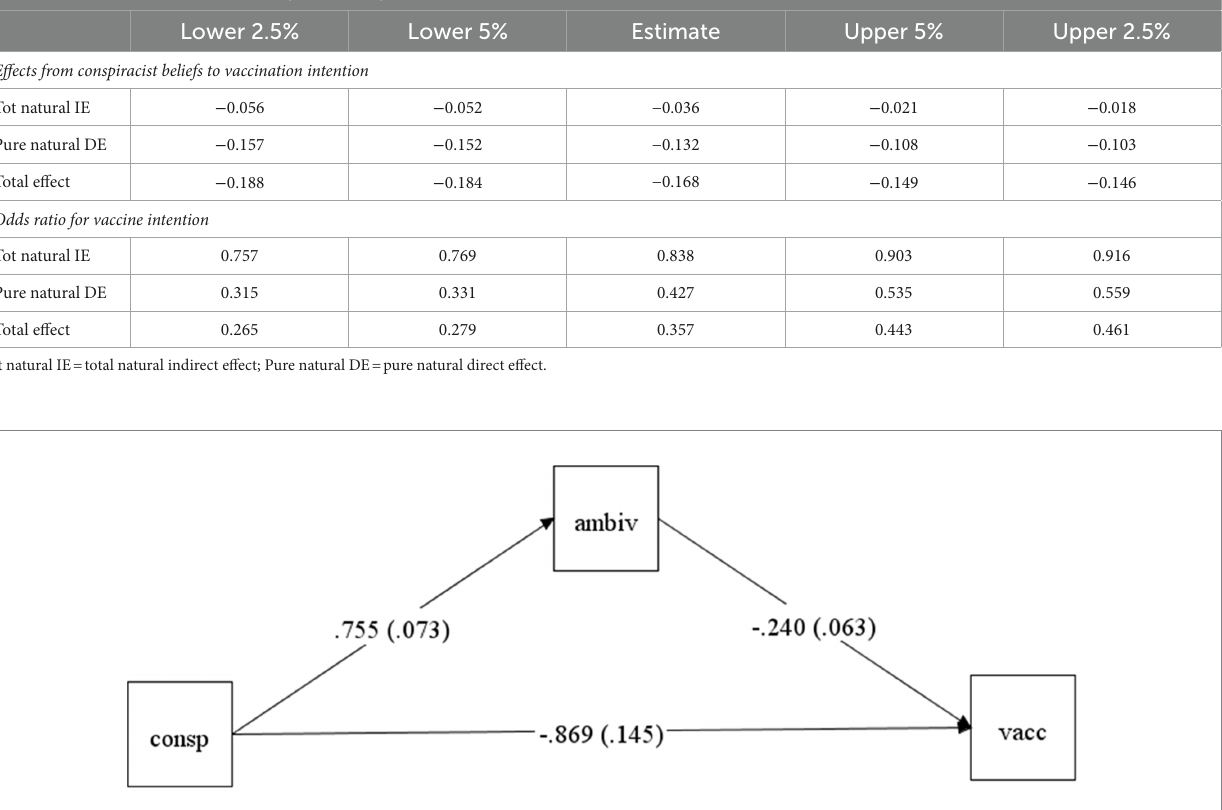
TABLE 5 Bootstrap confidence intervals using logit regression for vaccination intention. Confidence intervals of total, indirect, and direct effects based on counterfactuals Lower